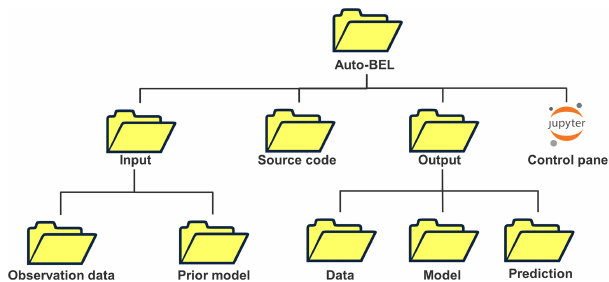
Figure 4. The structure of the AutoBEL python implementation